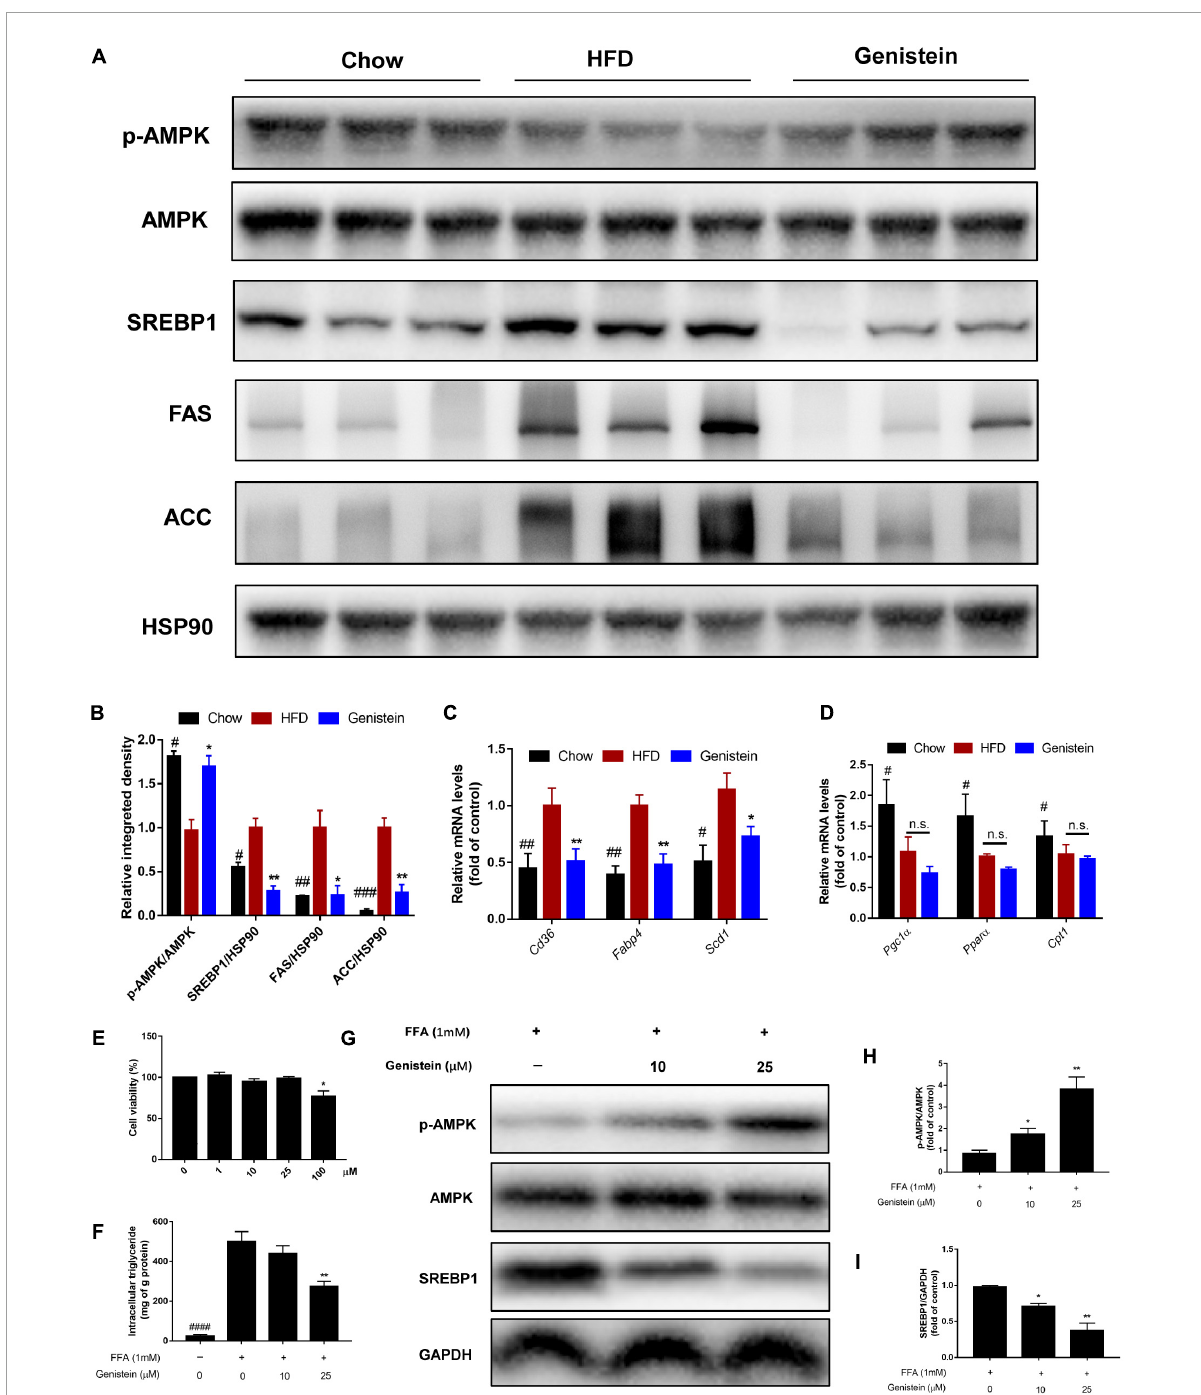
FIGURE6 Genistein suppresses hepatic de novo lipogenesis (A) Representative western blot of p-AMPK, AMPK, SREBP1, FAS, and ACC in liver tissue. (B) Relative integrated density of indicated proteins in liver of mice. (C) The mRNA levels of Cd36 , Fabp4 , and Scd1 in liver. (D) The mRNA levels of Pgc1 α , Ppar α and Cpt1 in liver. Data are presented as means ± SEM; n = 4–5 mice/group. # p < 0.05, ## p < 0.01, and ### p < 0.001 for Chow vs. HFD. * p < 0.05 and ** p < 0.05 for Genistein vs. HFD. (E) Cell viability was measured in HepG2 cells. (F) Intracellular triglyceride content in FFA-induced HepG2 cells treated with or without genistein. (G) Western blot for p-AMPK, AMPK, SREBP1 in FFA-induced HepG2 cells. (H) Quantification of the phosphorylation of AMPK. (I) Quantification of SREBP1 normalized to GAPDH. Data are presented as means ± SEM; n = 3. * p < 0.05 and ** p <